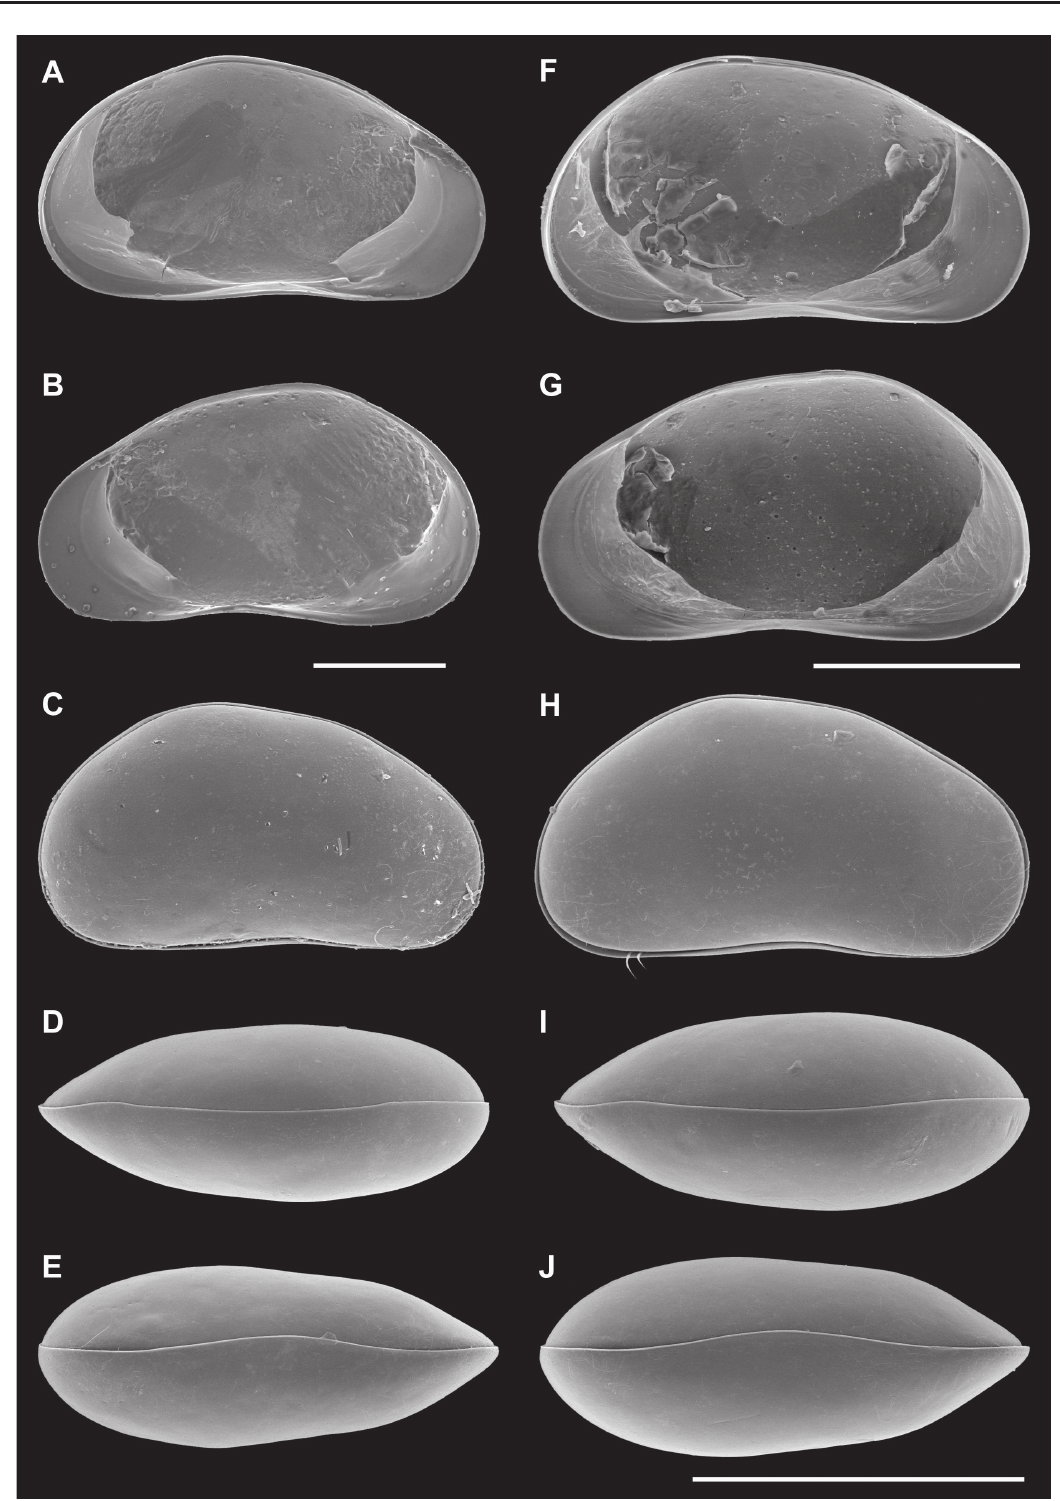
Fig. 6. Valves of Pseudocandona cillisi sp. nov. A–E ♂ and F–J ♀. A, F . LV, internal view (A = MZUSP 32681, F = MZUSP 32672). B, G . RV, internal view (B = MZUSP 32681, G = MZUSP 32672). C, H . Cp, right lateral view (C = MZUSP 32671, H = MZUSP 32678). D, I . Cp, dorsal view (D = OC. 3362, I = OC.3364). E, J . Cp, ventral view (E = MZUSP 32677, J = MZUSP 32680). Scale bars: A–B = 200 µ m; C–E, H–J = 500 µ m; F–G = 300